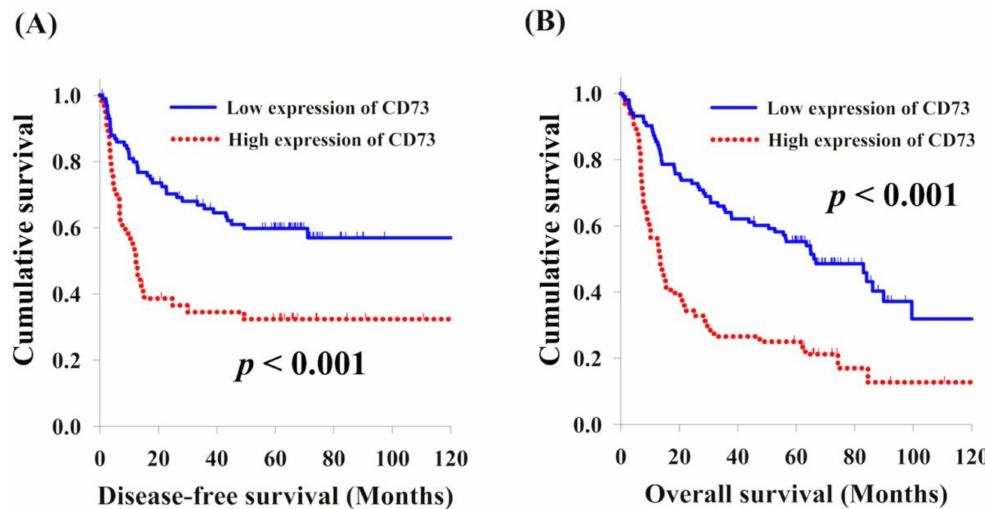
Figure 2. Comparison of the Kaplan–Meier curves of the patients with ESCC with high and low expression levels of CD73. ( A ) Disease-free survival and ( B ) overall